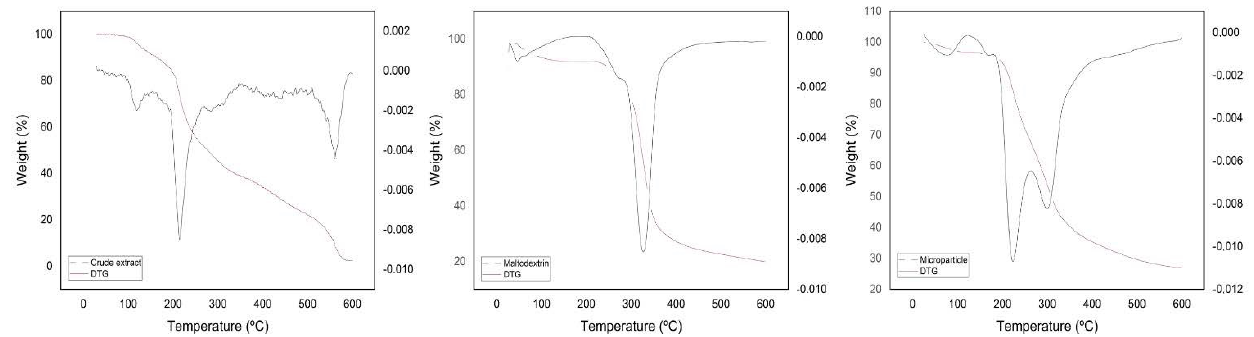
Figure 6. Thermogravimetry analysis (TG) ( − )/derived thermogravimetry (DTG) ( − ) curve of crude extract, microparticle and maltodextrin adjuvant. Conditions: nitrogen atmosphere (N 2 ), the flow of 50 mL/min and a heating rate of 10 °C/min.